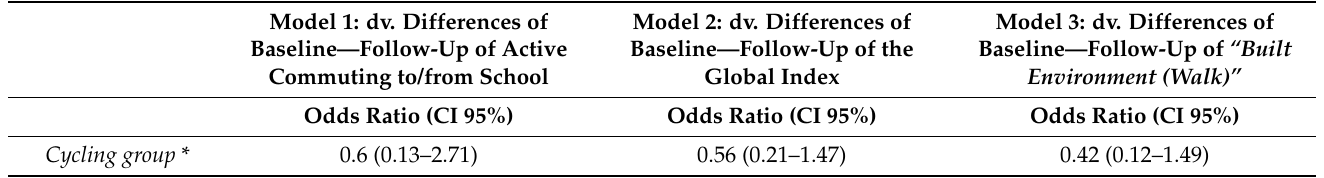
Table 4. Logistic regression of the differences in active commuting and perceived barriers at baseline and